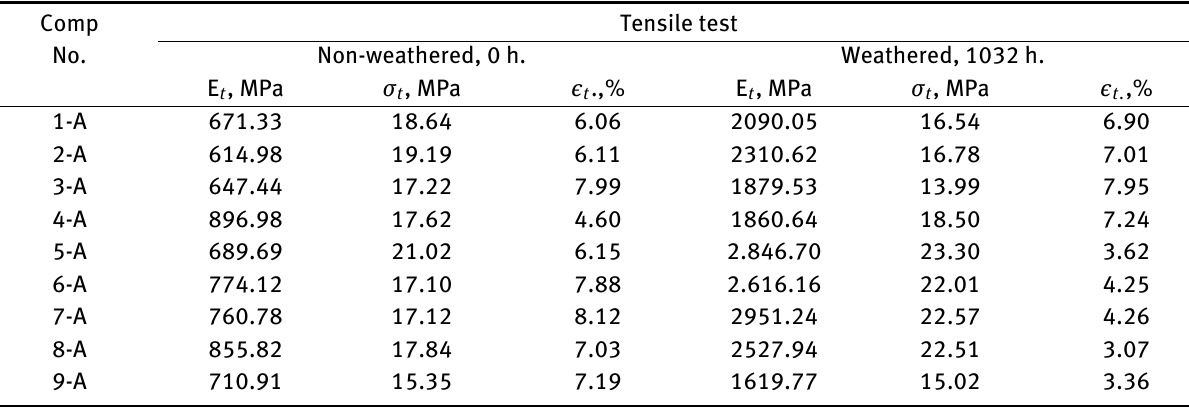
Table 8: Tensile test results before and after 1032 h of the weathering Comp Tensile test No. Non-weathered, 0 h. Weathered, 1032